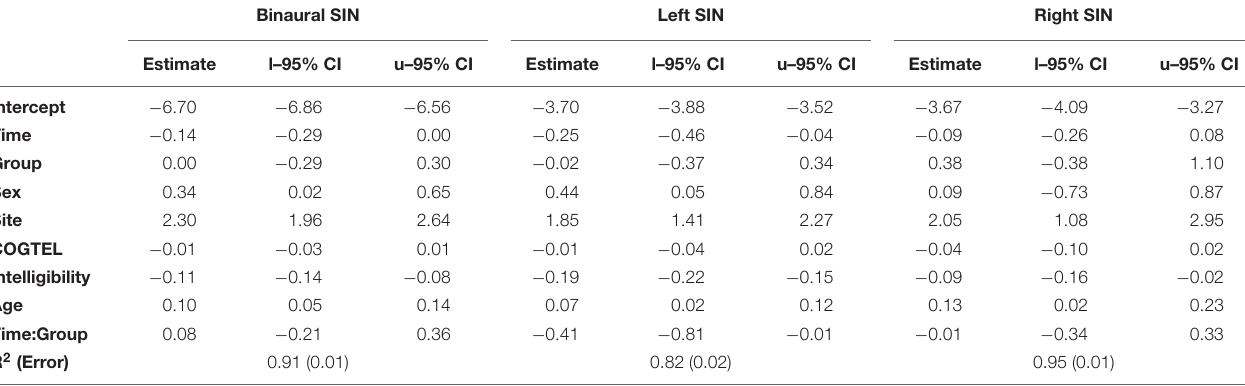
TABLE 2 | Population-level effects of the two-way-interaction models.